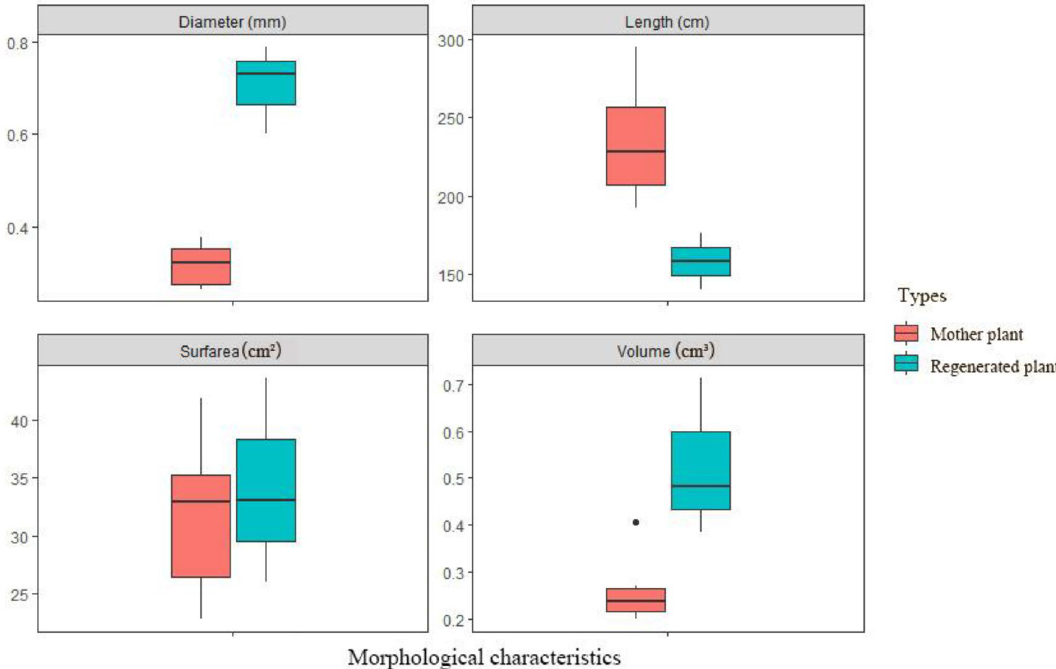
Figure 7. Box-whisker plots for two types of Morphological characteristics in rhizomes both inventories with median and inter quartile ranges; whiskers extend to 1.5 times the inter quartile range. Note the log-scaled